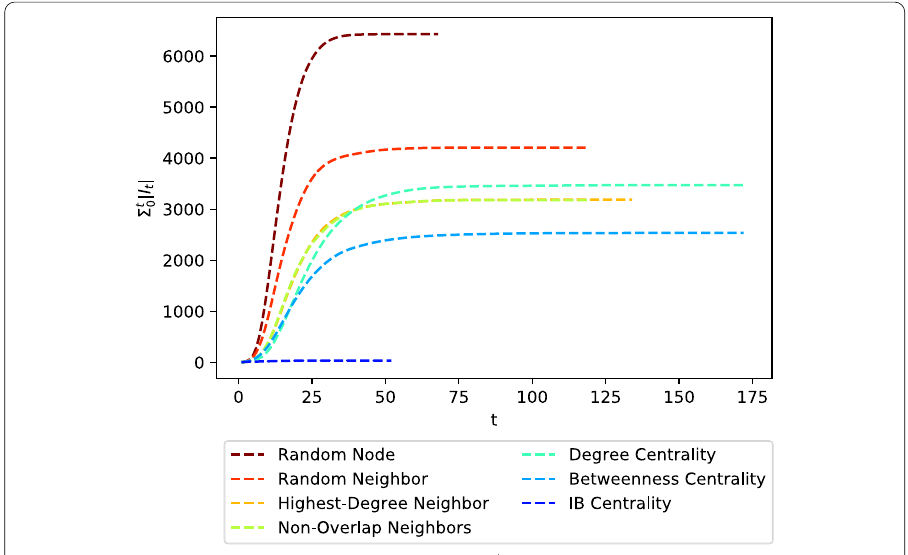
Fig. 6 Cumulative number of infected nodes along time curve, with a very low number of infected nodes (close to zero) during the entire contagion process